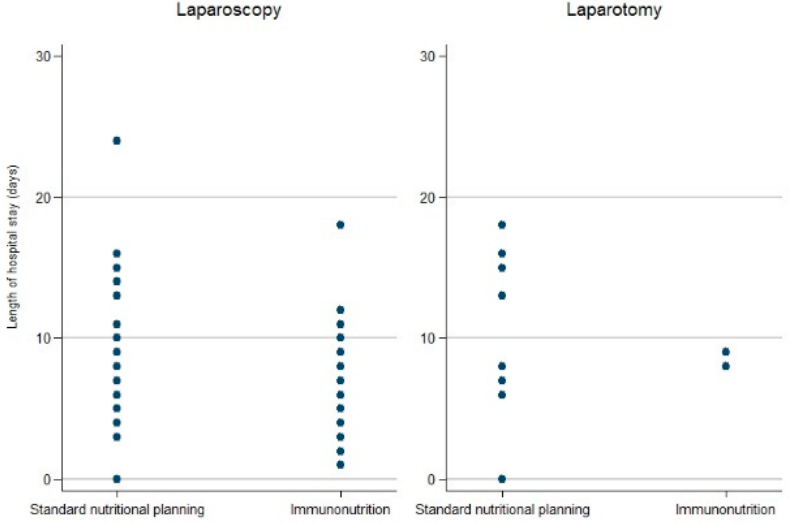
Figure 2. Length of hospital stay in IN and non ‐ IN group according to surgical procedure (laparoscopy versus laparotomy), scatter plot.